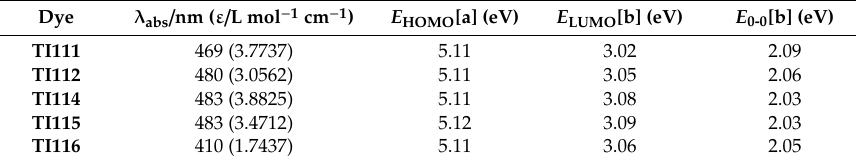
Table 1. Electrochemical properties for TI111 – TI116 dyes.